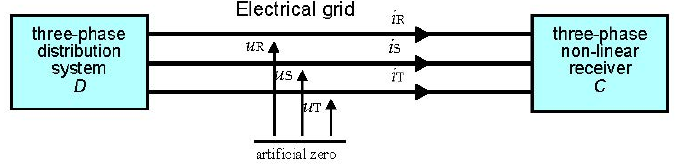
Figure 1. Connection of a non-linear receiver ( C system) and a three-phase source ( D system) via a three-wire network.